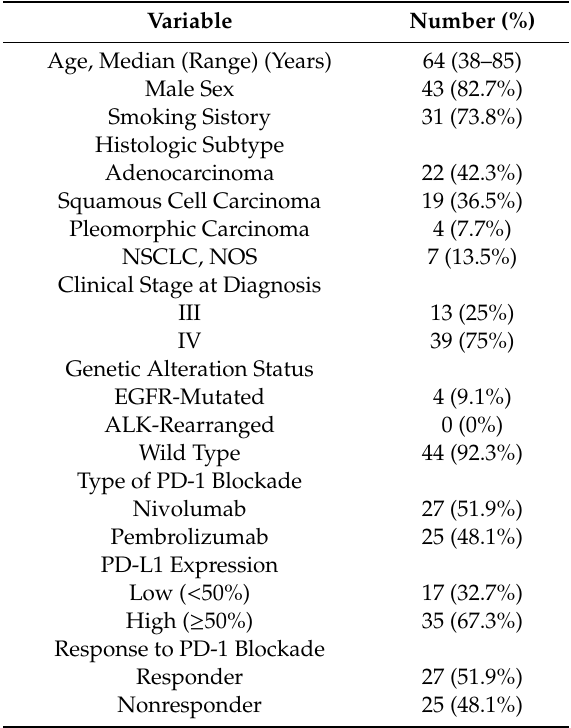
Table 1. Demographic and clinical characteristics of patients.